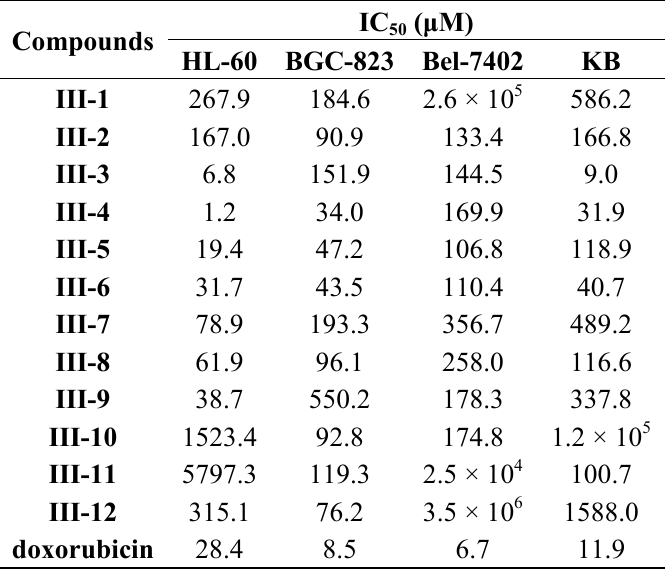
Table 4. Antitumor activity of the title